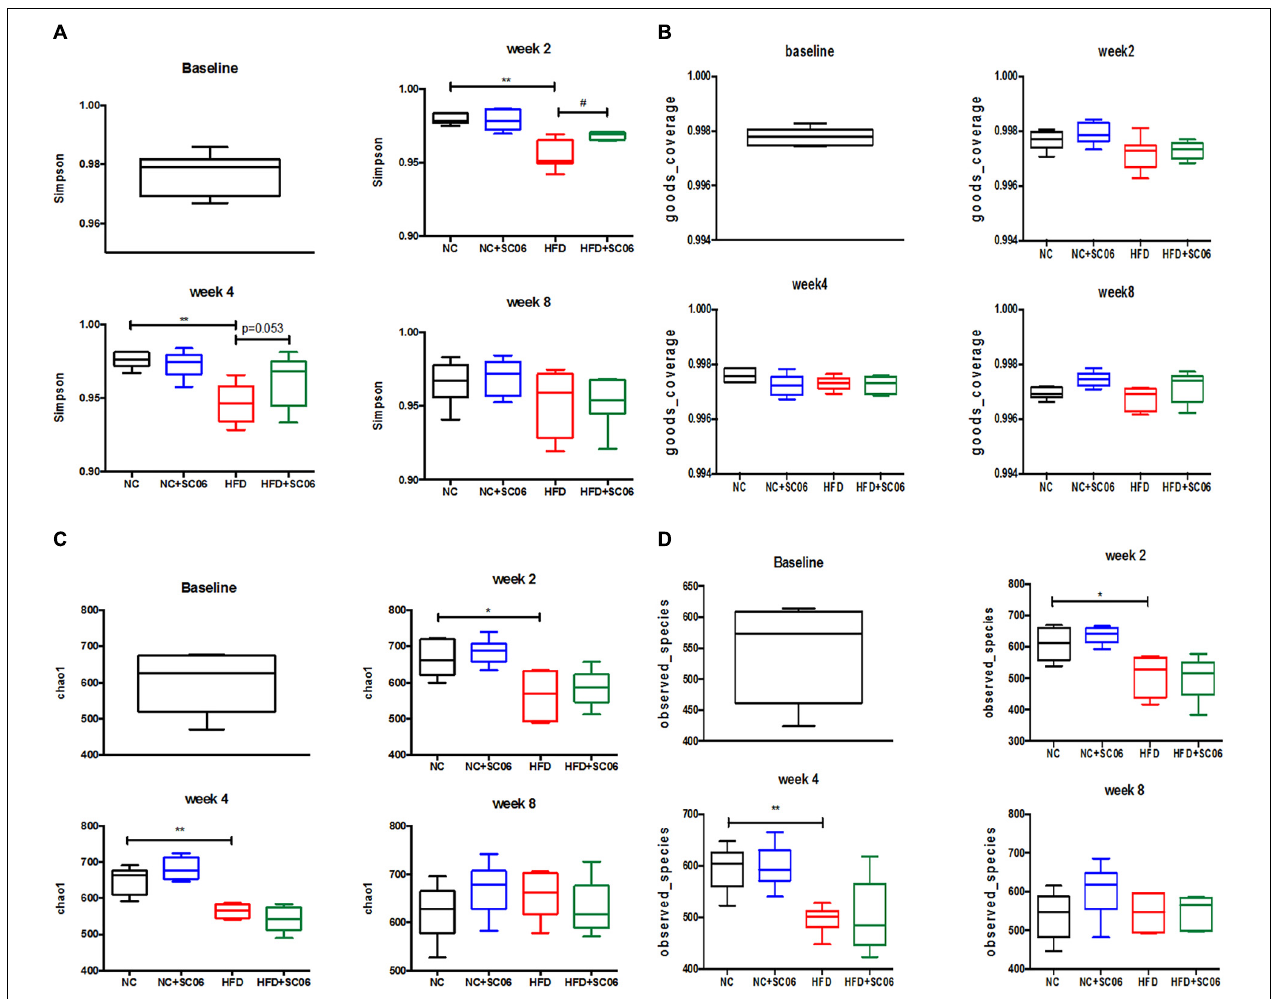
FIGURE 5 | Changes in a-diversity of gut microbiota communities, as measured by (A) Simpson’s, (B) Goods_coverage’s, (C) Chao1’s, and (D) Observed_species’ Index Calculator. Differences between groups were determined by one-way ANOVA followed by Tukey’s t -test ( n = 5). Significant differences between HFD versus NC are indicated as ∗ p < 0.05, ∗∗ p < 0.01. Significant differences between HFD versus HFD+SC06 are indicated as # p <